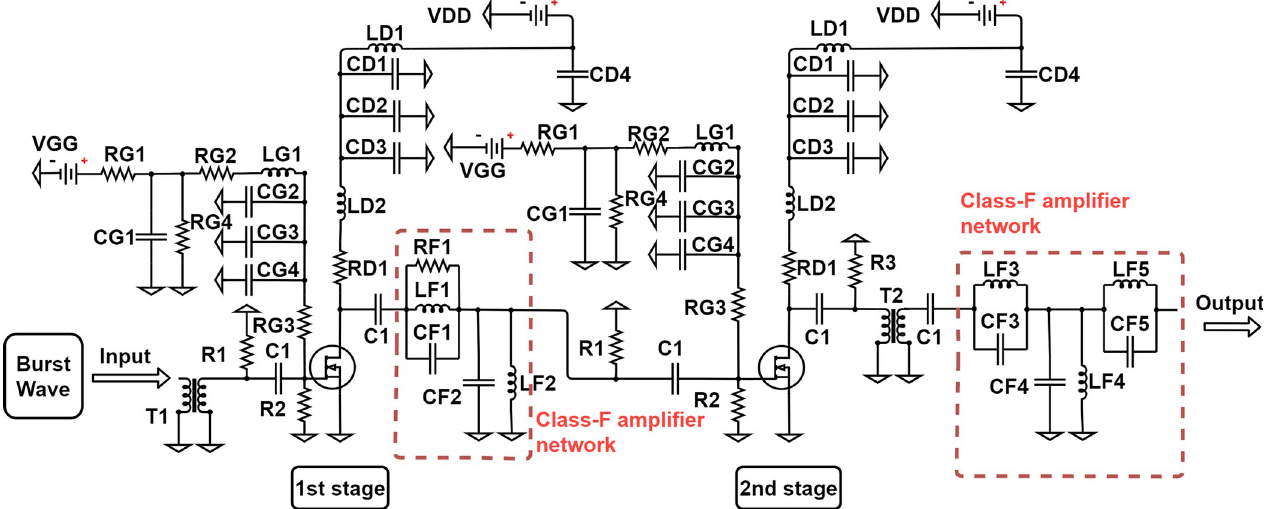
Fig 5. Designed two-stage high efficiency and high voltage class F amplifier schematic diagram.